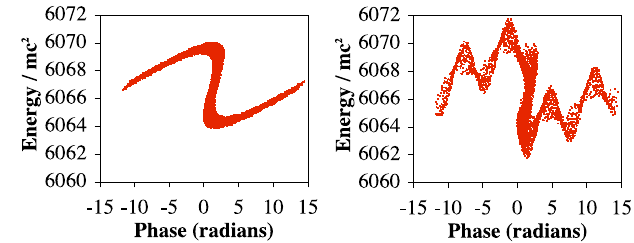
FIG. 7. (Color) Longitudinal phase space of a prebunched elec- tron beam after harmonic generation at 50 nm. The low-current limit (left) is compared with the nominal case where the beam is modulated by its own radiation